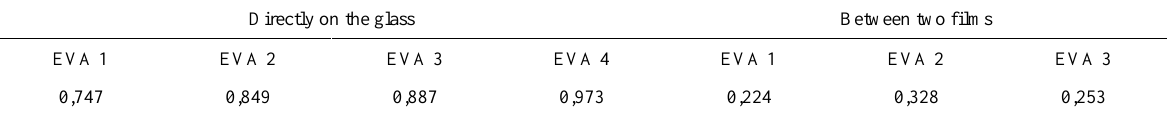
Table 6: Average luminescence of the samples with sprayed paint (lux) Directly on the glass